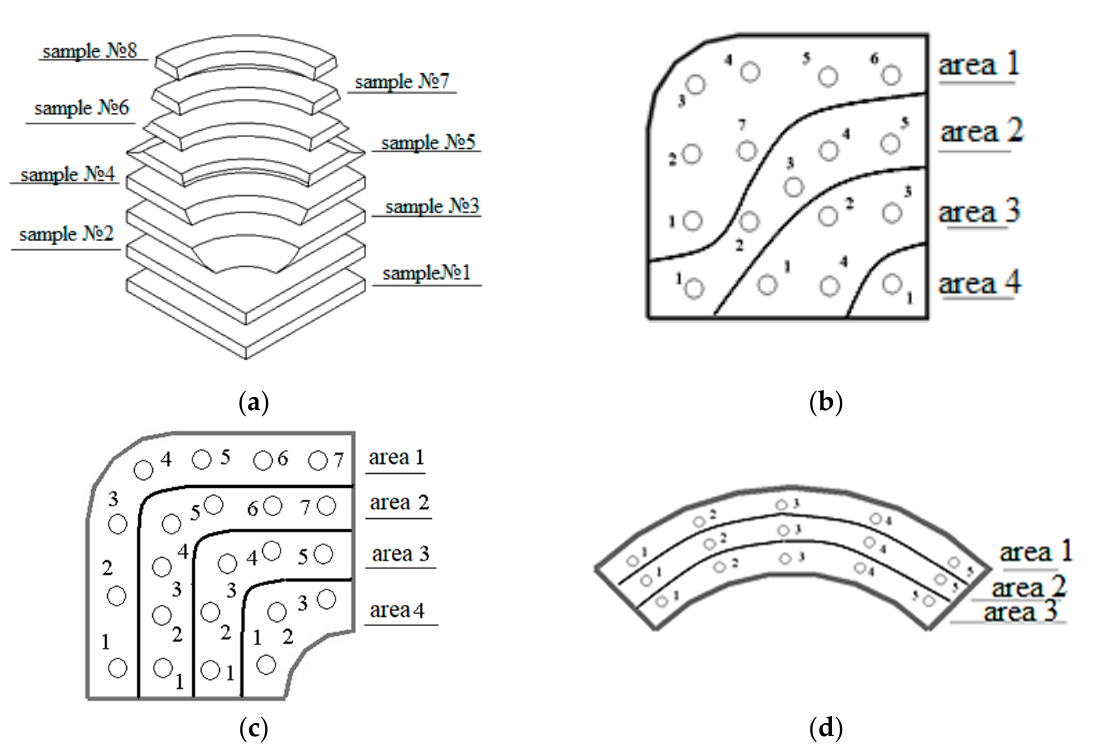
Figure 4. Diagram of cutting the fourth part of the flange forging ( a ) into layered samples; designation of research areas on sample № 1 ( b ); sample № 3 ( c ) and sample № 7 ( d ).